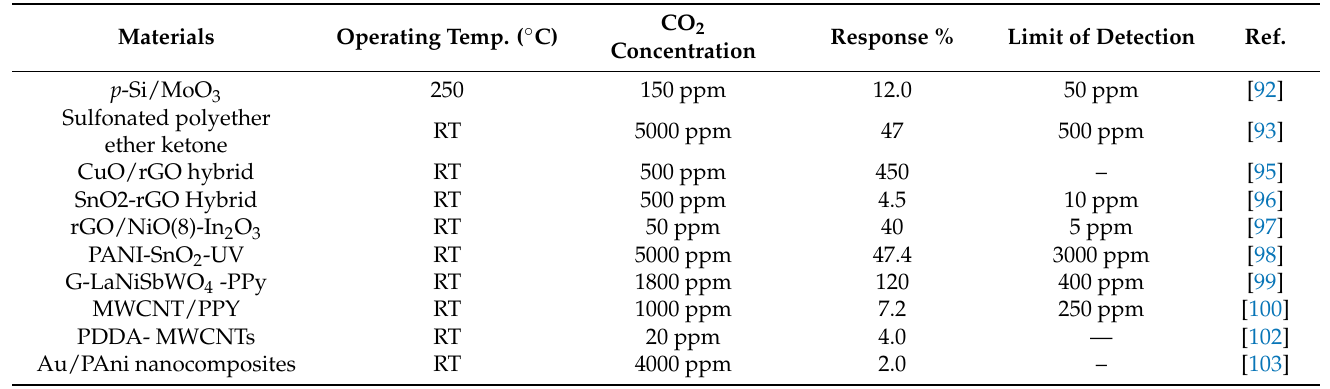
Table 4. The most recent chemiresistive CO 3 sensors reported in the